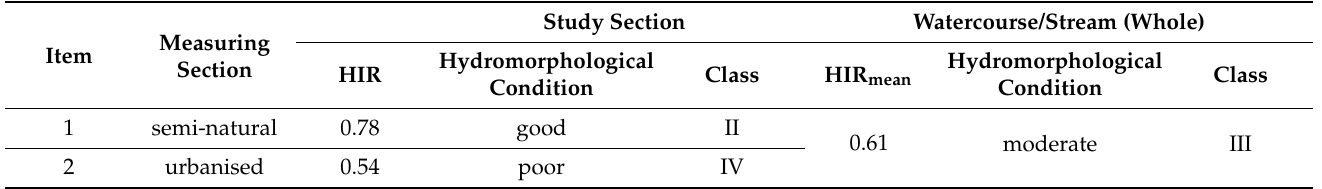
Table 5. Results of hydromorphological evaluation and quality classes of individual examined sections and the whole